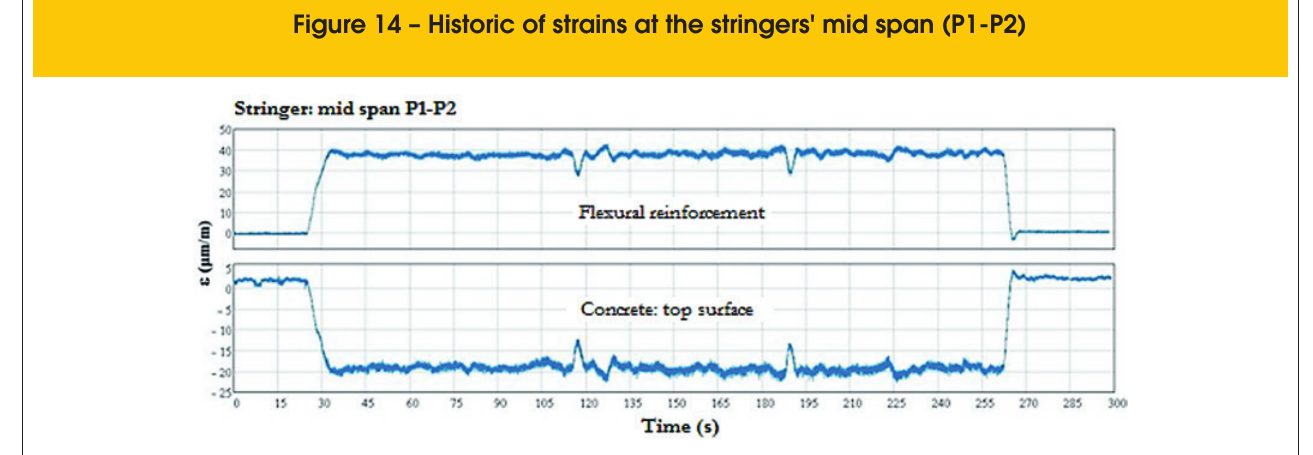
Figure 14 – Historic of strains at the stringers' mid span